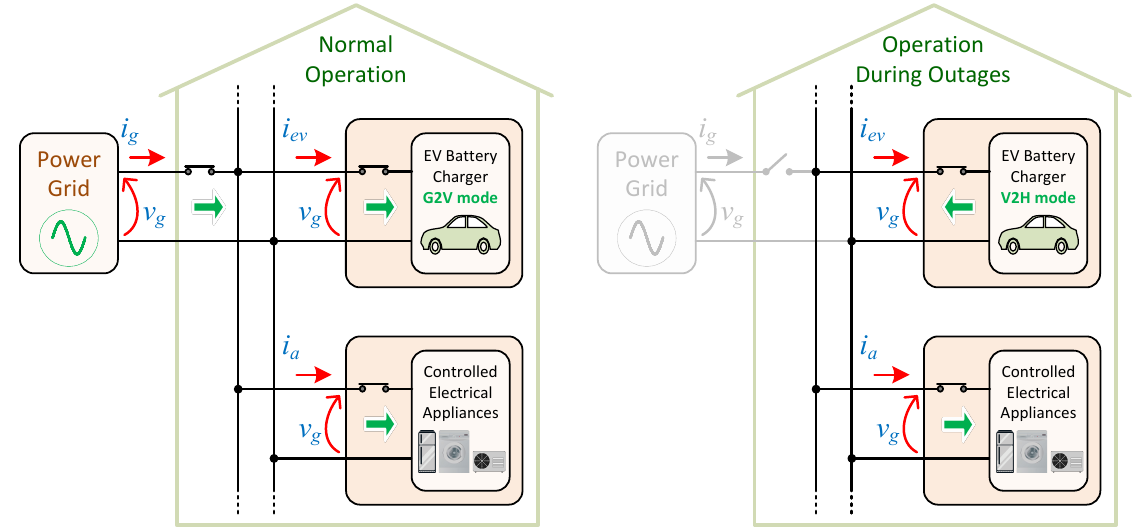
Figure 1. Introduction of the EV charger into a smart home during: (a) Operation in G2V mode (charging the batteries); (b) Operation in V2H mode (as an off-line UPS to supply the smart home electrical